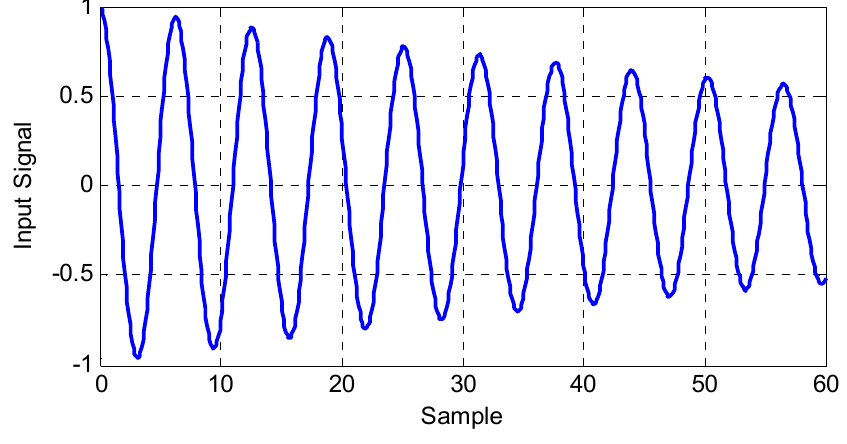
Figure 1. The input signal of test system 1.